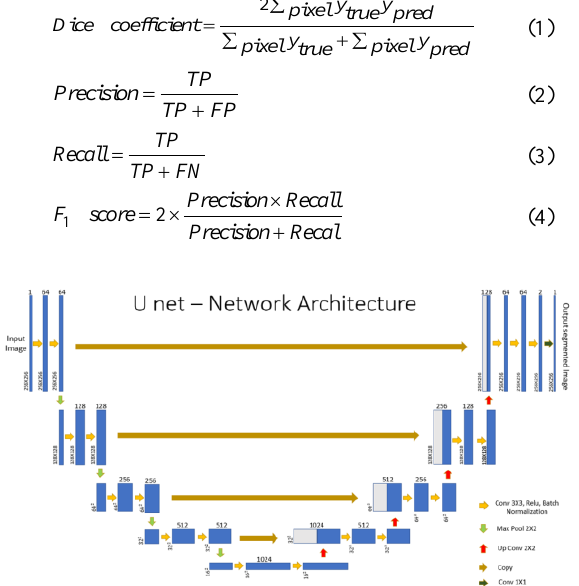
Figure 7. U-net architecture (adapted from Ronneberger et al. [20])